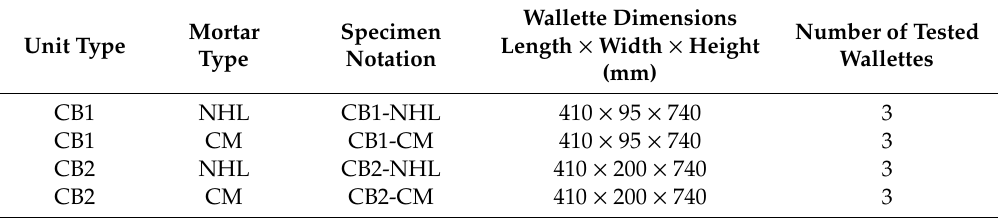
Table 6. Test matrix and dimensions of the specimens.